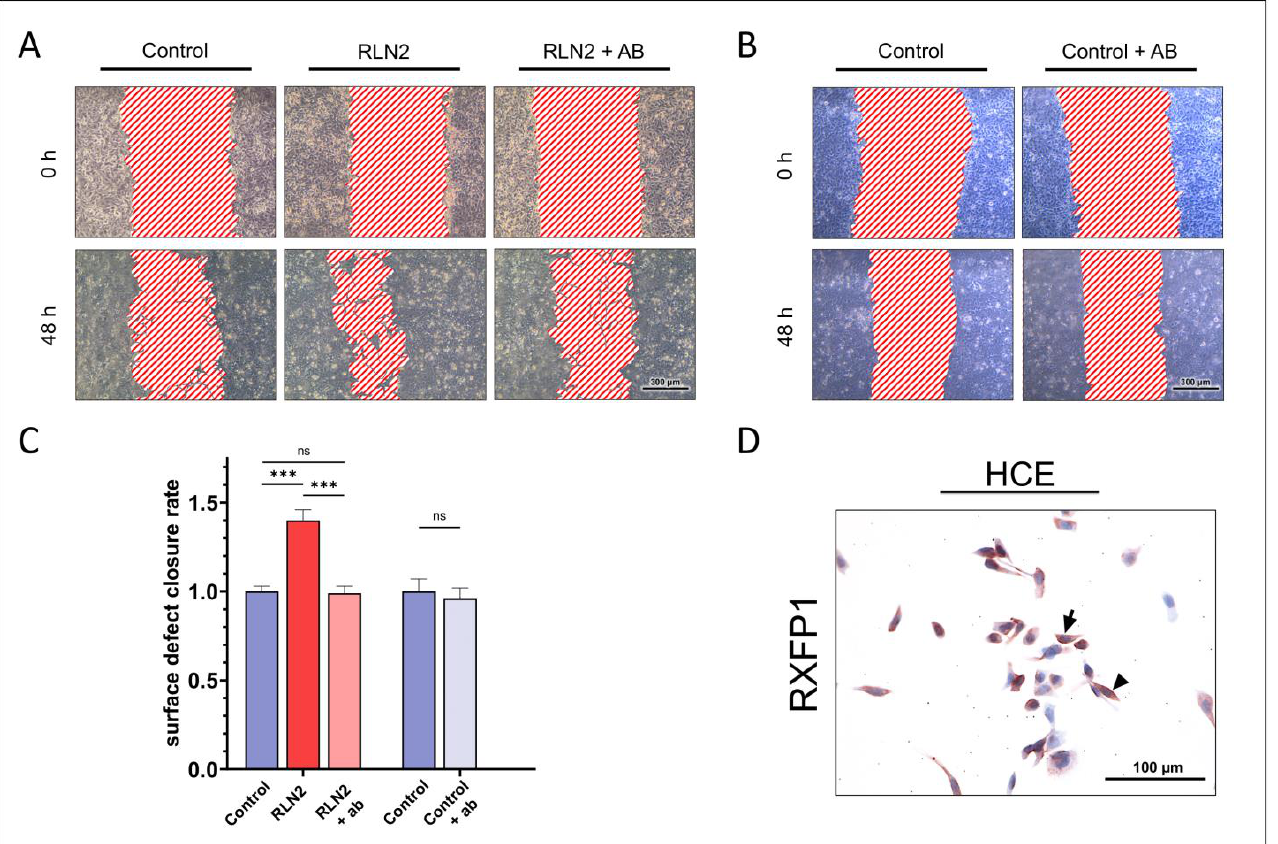
Figure 8. Scratch assays confirm inhibition of RXFP1. ( A , B ) show representative scratch assays in human corneal epithelial cells (HCE). Epithelial wound closure in cells stimulated with 100 ng/mL Relaxin-2 (RLN2, positive control) ( A ) or untreated cells (negative control) ( B ) was observed, respec- tively, with or without the presence of 3 mg/mL of a specific inhibitory anti-RXFP1 antibody (ab). The surface defect was measured in a representative segment of a scratch ( n = 9) at different time points and compared to untreated HCE cells (control). ( C ) Fold-increase in the surface defect closure rate. Bars represent mean ± SEM. RLN2 significantly increased the surface defect closure rate com- pared to the untreated control (one-way ANOVA; *** p < 0.001). The presence of the inhibitory anti- RXFP1 antibody significantly reduced the effect of RLN2 on the surface defect closure rate (one-way ANOVA; *** p < 0.001). There were no significant differences in the surface defect closure rate be- tween the untreated control and HCE that were treated with RLN2 but also underwent RXFP1 in- hibition (one-way ANOVA; ns = not significant, p > 0.05). The antibody alone did not significantly alter the surface defect closure rate (unpaired t-test; ns = not significant, p > 0.05). ( D ) RXFP1 protein expression was confirmed prior to scratch assays in HCE cells via immunohistochemistry. The an- tibody reaction can be seen by the red reactivity. Nuclei are counterstained with hemalum (blue). Arrows and arrowheads accentuate the reactivity localization. Three individual experiments were performed.